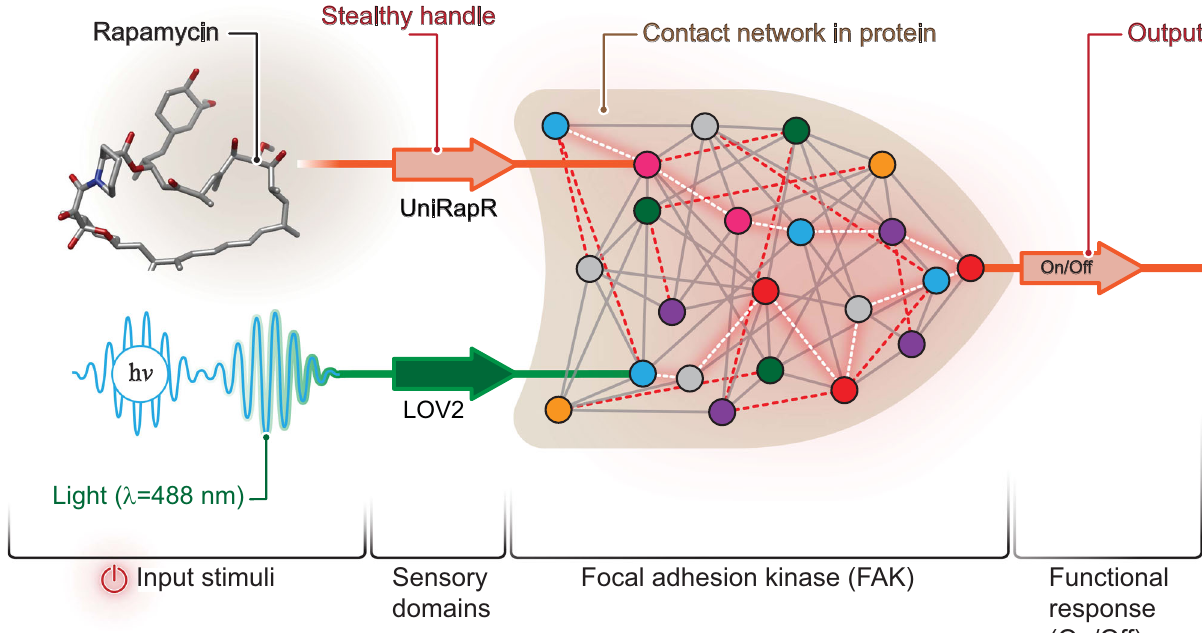
Fig. 1 ChOp -FAK resembles digital two-input logic OR gate. Chop -FAK is allosterically regulated by inserted sensor domains uniRapR and LOV2, which serve as input response elements. Rapamycin and light are the input signals for uniRapR and LOV2, respectively. From the sensor domains signals propagate through the amino acid core network (shown as contact network) of the protein. The output is FAK